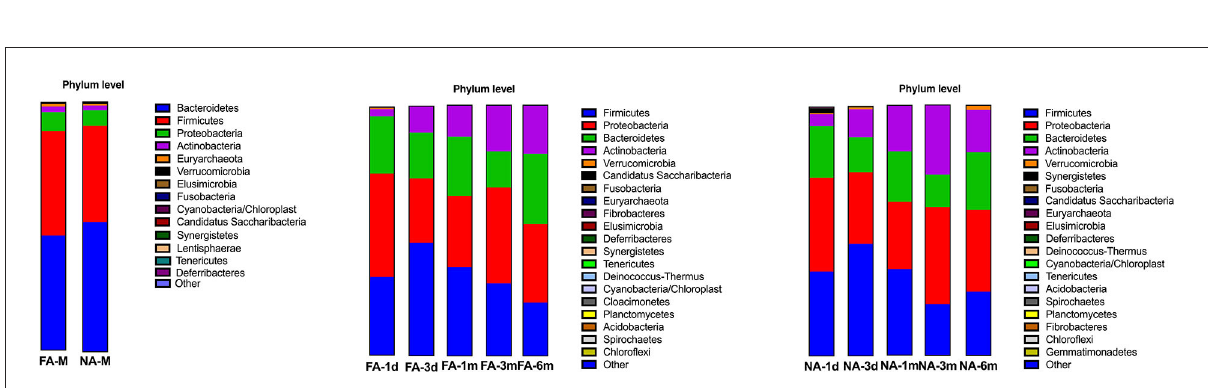
FIGURE5 Bacterial phyla in the maternal and infant cohorts in the non-allergy (NA) and food allergy (FA)